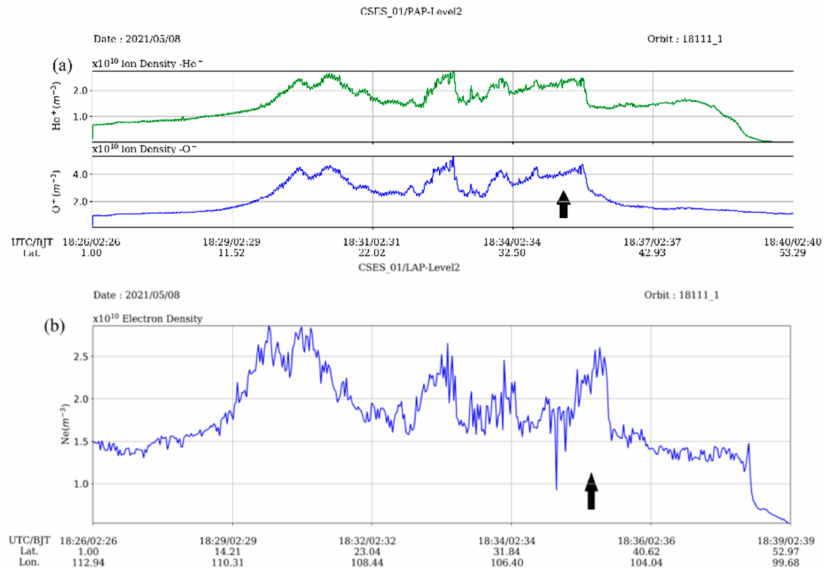
Figure 7. Fluctuations of ( a ) He + and O + densities and ( b ) electron density registered by the CSES satellite on 8 May 2021, 14 days before the Maduo M S 7.4 EQ. Obvious variations associated with this Maduo event are labeled with black